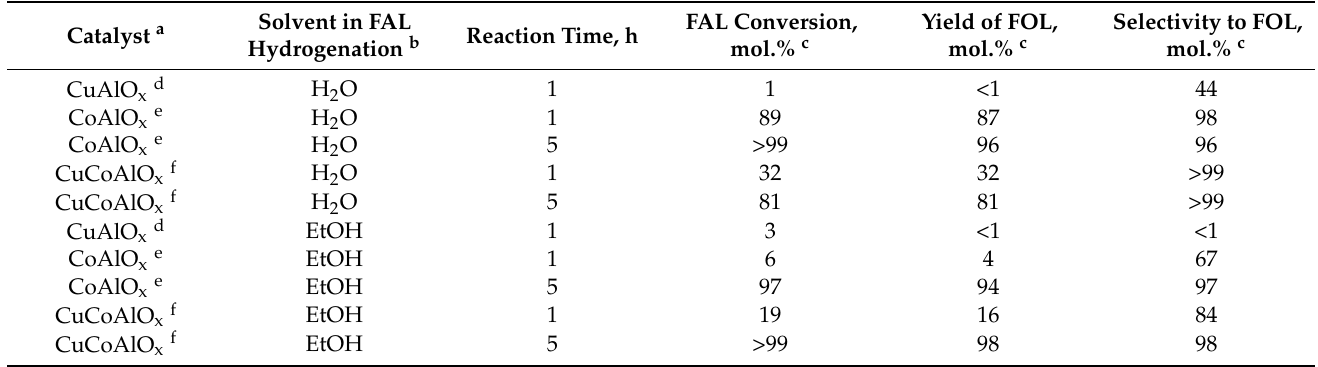
Table 3. Results of FAL hydrogenation in the presence of CuAl- CoAl- and CuCoAl-catalysts in the water and ethanol media.